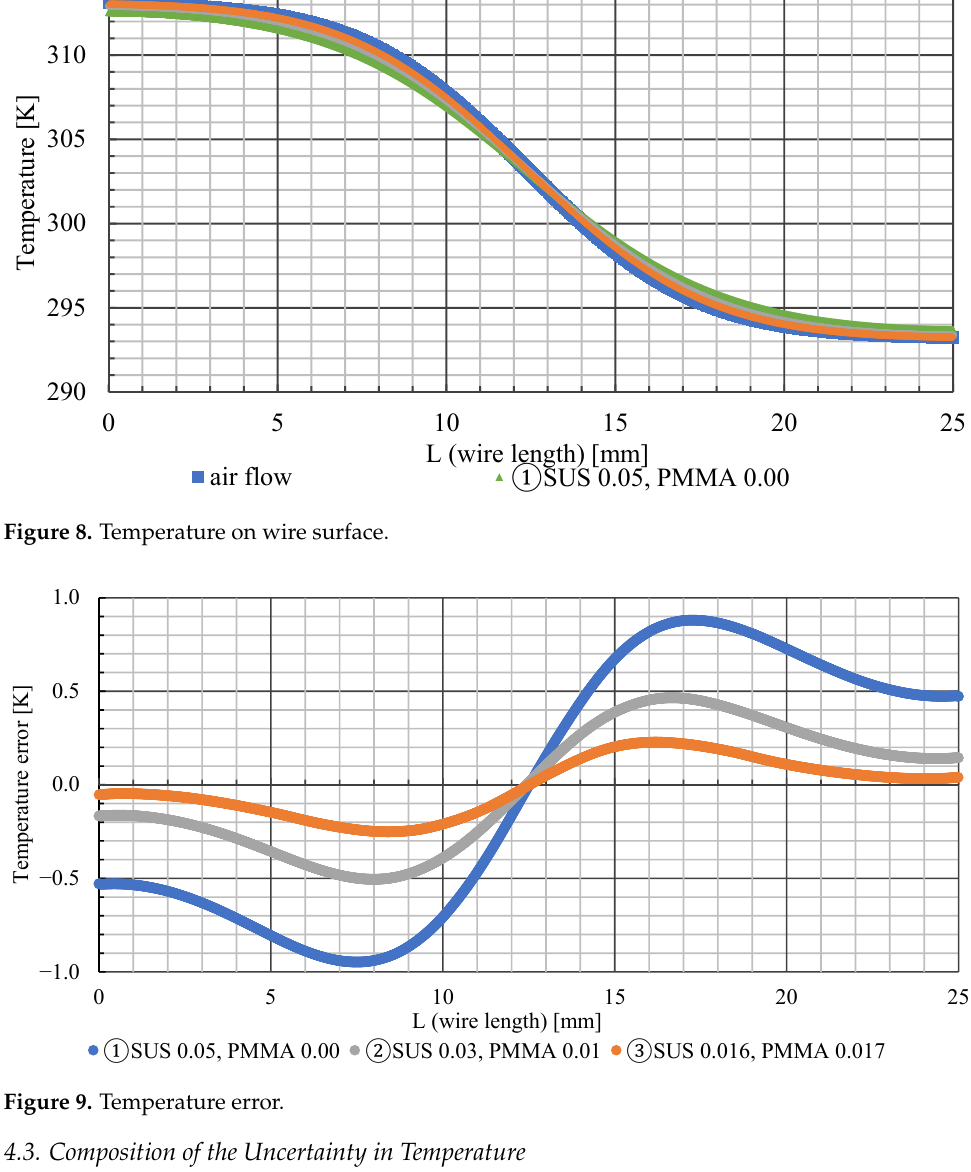
Figure 9. Temperature error.